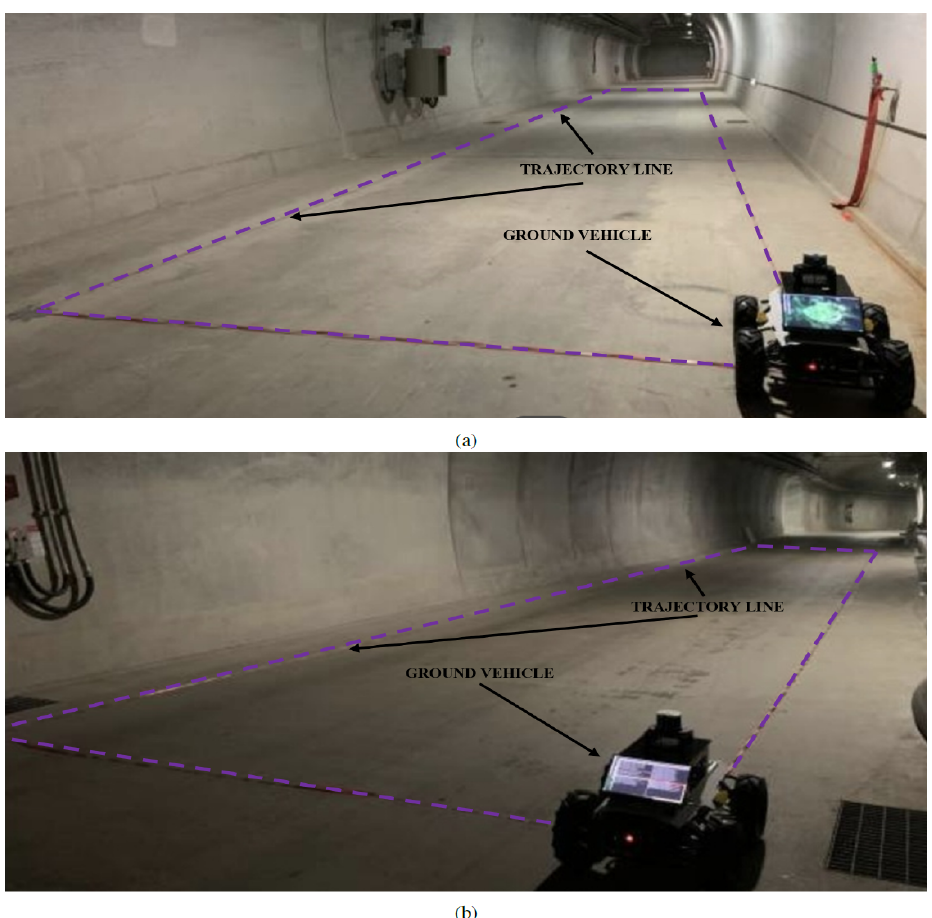
Figure 5. Experiment setup in the tunnel environment: ( a ) flat (horizontal) terrain section and ( b ) inclined terrain